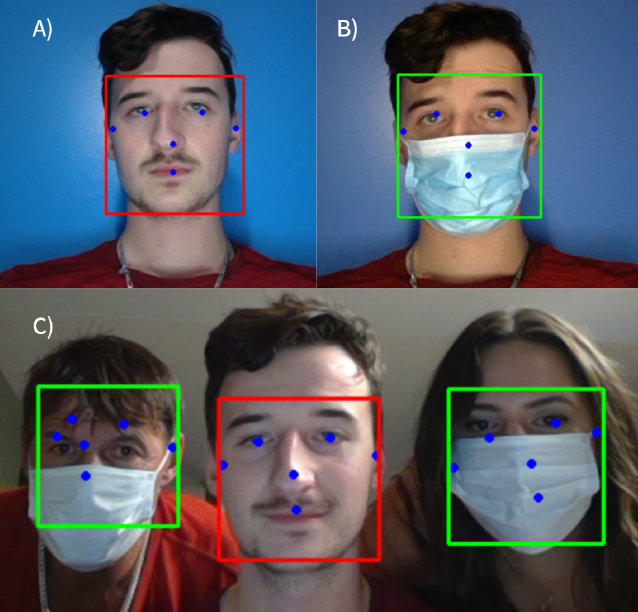
Figure 6. Sample outputs of baseline MaskDetect: ( A ) single-instance detection with mask off; ( B ) single instance detection with mask on; ( C ) multi-instance detection